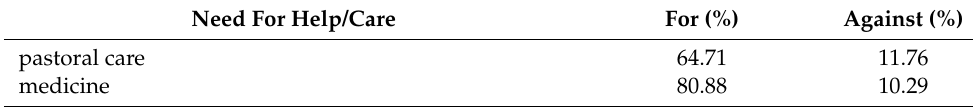
Table 2. Assessment of the provision of other needs during post-COVID-19